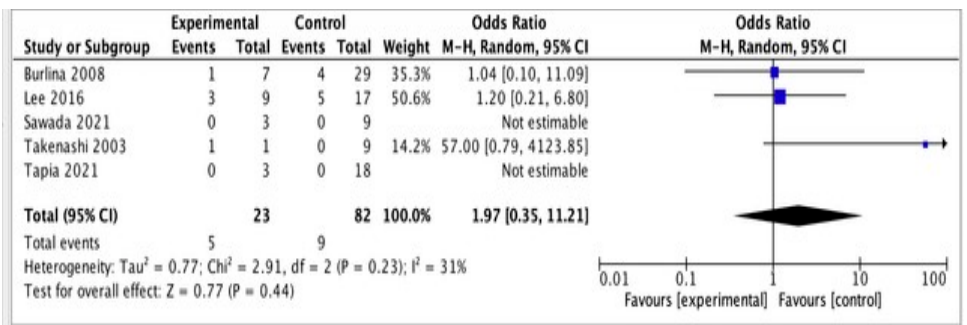
but no related stroke. Patients with the PS do not have higher odds of having a stroke 1.97 (0.35, 11,21) 95 CI% ( p = 0.44).